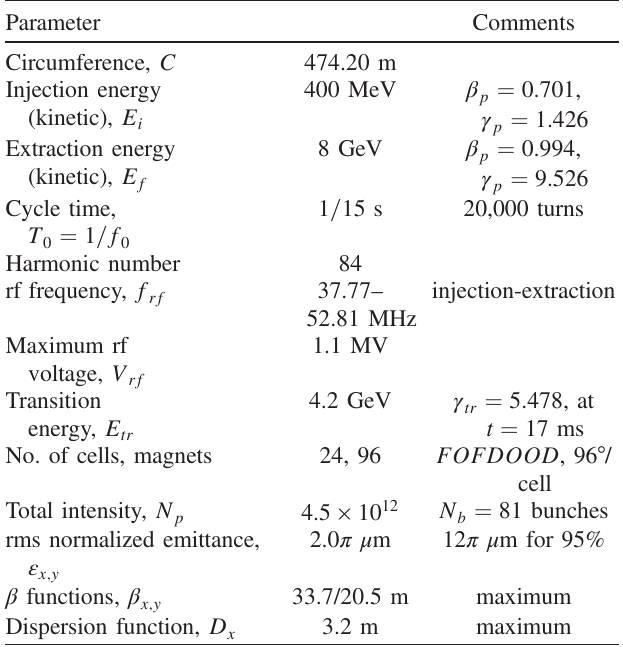
TABLE I. Main operational parameters of the Fermilab Booster. β p and γ p are relativistic Lorentz factors of